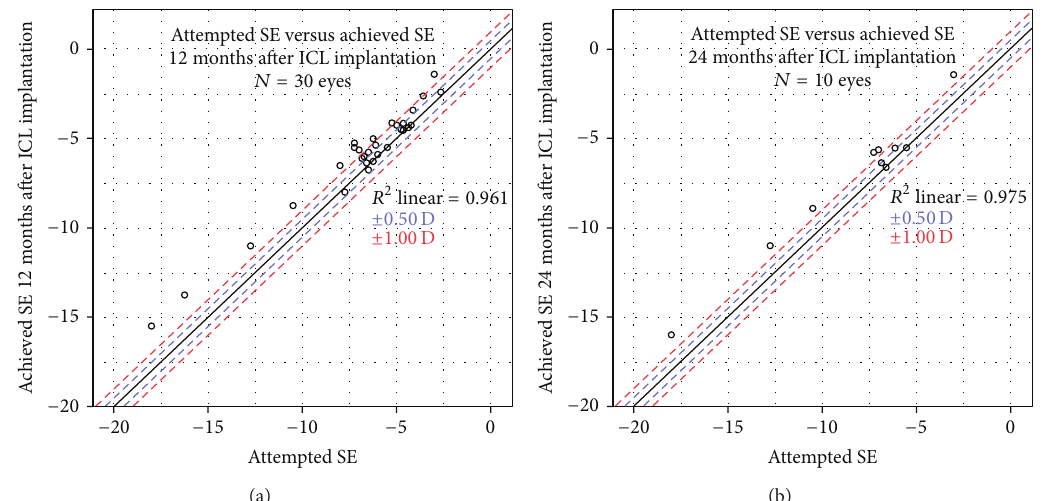
Figure 2: Attempted and achieved spherical equivalent (SE) correction at (a) 12 months and (b) 24 months after implantable collamer lens (ICL) implantation,